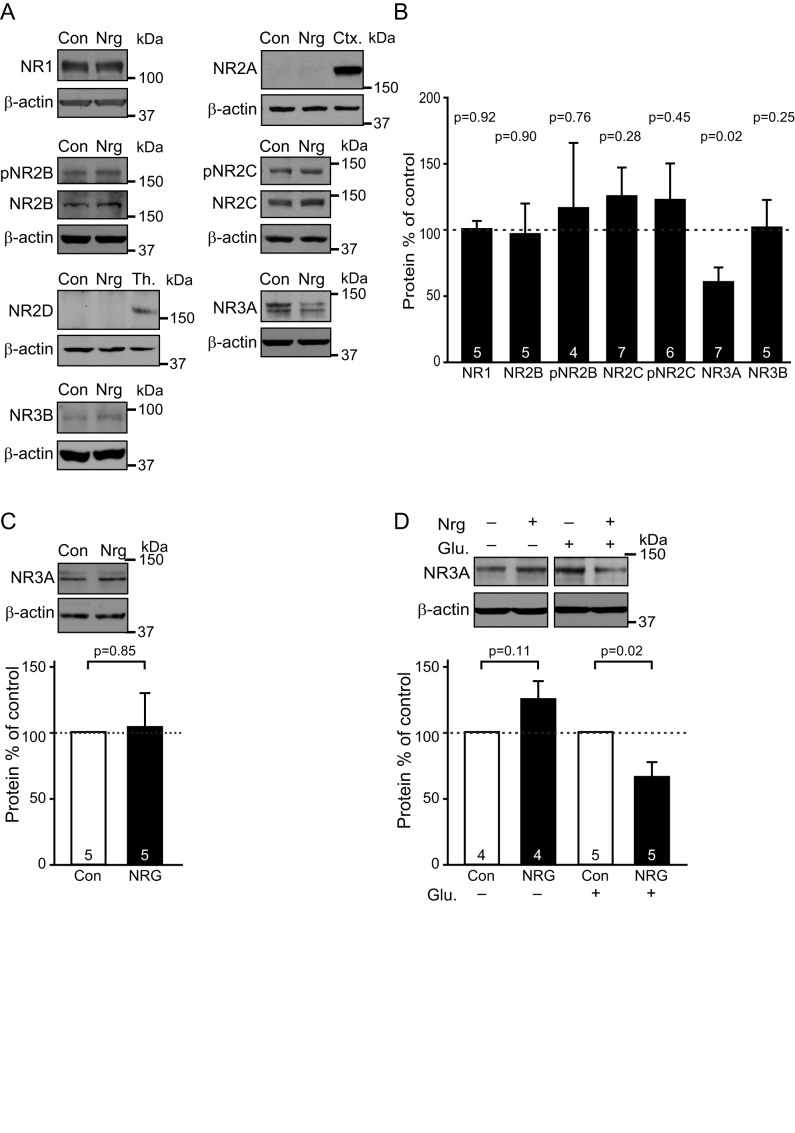
Expression of NMDA receptors.(A) Western blots of control and NRG-treated cocultures for NR1, NR2B and its phosphorylated form (pNR2B), NR2C and its phosphorylated form (pNR2C), NR3A and NR3B, as well as for NR2A and NR2D compared to their respective positive controls of rat cortex (Ctx) and thalamus (Th); β-actin acts as a loading control throughout. (B) Densitometric quantification of subunit protein levels in cocultures (normalized to β-actin) in NRG normalized to the levels in control (NR2A and NR2D levels were undetectable). (C) Western blot of control (Con) and NRG-treated pure DRG cultures for NR3A and (below) densitometric quantification of subunit protein levels (normalized to β-actin and then to control). (D) Western blot for NR1 and NR3A of control (Con) and NRG-treated (for 6 d) pure OPC cultures, treated (+) or not treated (−) with 20 min glutamate (Glu, 100 µM) stimulation every day, with densitometric quantification of subunit protein levels (normalized to β-actin and then to control). The p values over the bars, in (B) from Holm–Bonferroni corrected t tests and in (C and D) from one-sample Student t tests, compare with control; numbers of experiments shown on bars.